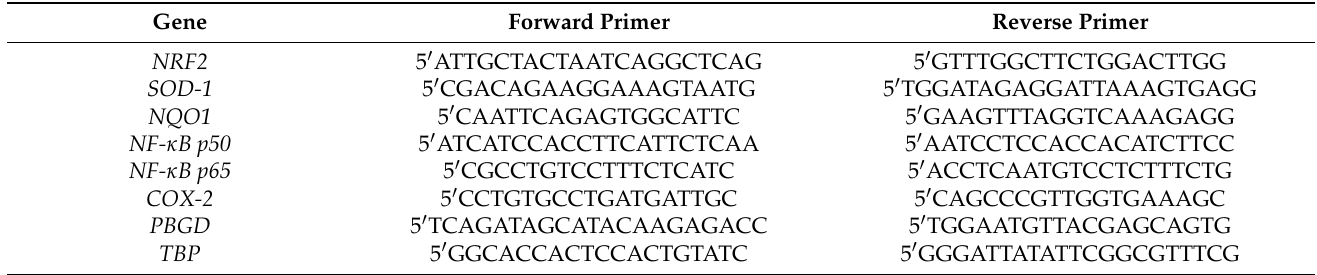
Table 2. Primers used in the